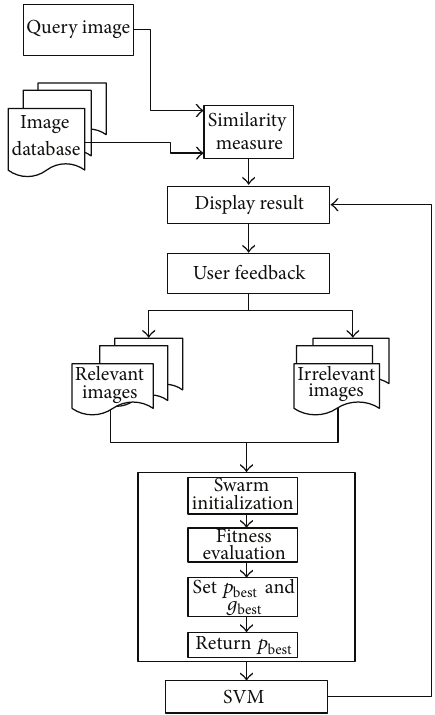
Figure 1: Flow chart of the proposed